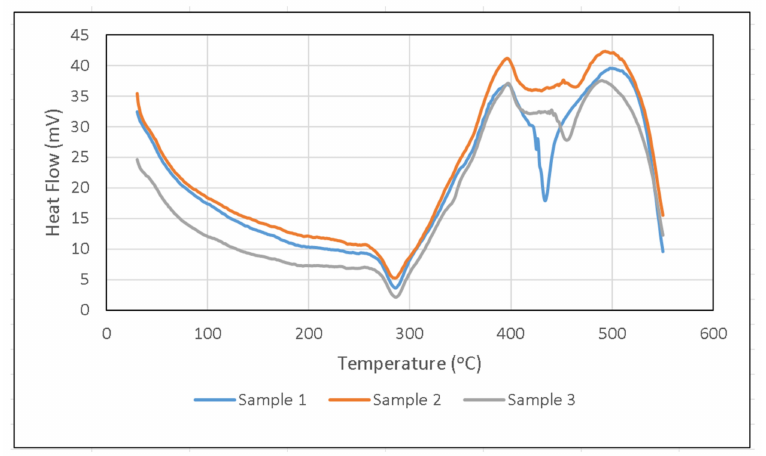
Figure 12. DSC curve